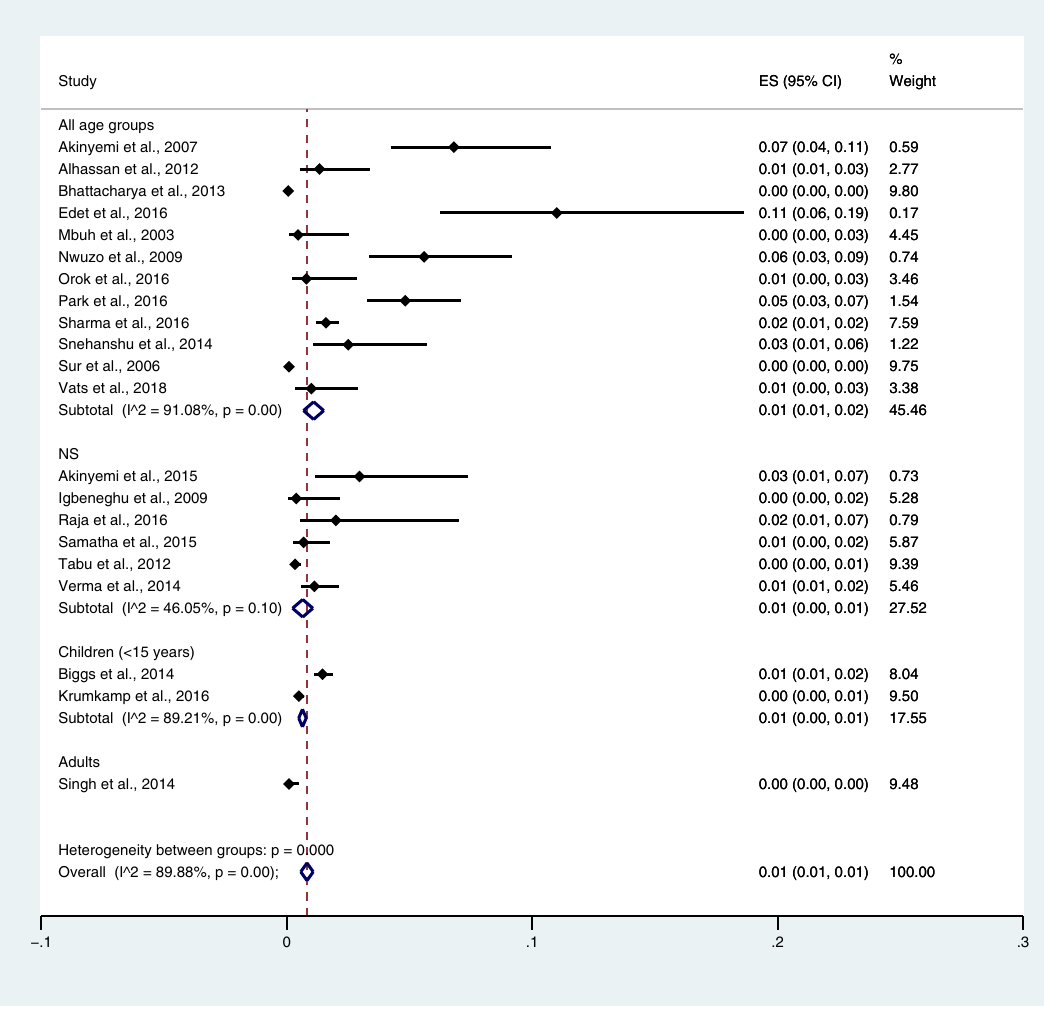
Figure 6. Pooled prevalence of typhoidal/NTS and malaria co-infection using blood cultures for the identification of Salmonella spp. infection stratified by age groups. ES proportion estimate (multiply 100 units for interpreted as prevalence estimate), CI confidence interval, NS not spp. was 17% in children (95% CI 6–29%; I 2 , 33.3%) (Fig. 22). The pooled prevalence rate of malaria infec- tion among patients with NTS, which was estimated from six studies 17,20,27,29,31,49 , was 43% in children (95% CI 32–53%; I 2 , 89.1%) (Fig. 23). Probability of Plasmodium spp. and Salmonella spp. co‑infections. The prob- ability of Plasmodium spp. and Salmonella spp. co-infections was estimated from 46 studies 35–38,40,41,43–47,50–53,57,59,61,64–66,68,70,71,73,75,76,81,82,84,87,90–93,95–97,99–104,106,108 , which reported the following param- eters: total number of Plasmodium spp. and Salmonella spp. co-infections, total number of malaria, total number of malaria without typhoid, and total number of febrile patients without malaria/typhoid. Plasmodium spp. and Salmonella spp. co-infections in all age groups occurred by chance (p = 0.126; odds ratio, 1.51; 95% CI 0.89–2.58; I 2 , 95.7%), whereas Plasmodium spp. and Salmonella spp. co-infections in children did not (p < 0.0001; odds ratio, 0.36; 95% CI 0.23–0.58; I 2 , 73.9%). No association between Plasmodium spp. and Salmonella spp. infec- tions was observed in the NS age group (p, 0.24; odds ratio, 0.40; 95% CI 0.09–1.85; I 2 , 86%) or adults (p, 0.799; odds ratio, 1.14; 95% CI 0.41–3.16; I 2 , 94%). Overall, Plasmodium spp . and Salmonella spp. co-infection occurred by chance (p, 0.987; odds ratio, 1.00; 95% CI 0.68–1.49; I 2 , 95.2%) (Fig. 24). A significantly higher odds ratio of co-infection was reported in Nigeria 57,59,82,90,95,97,101 , Cameroon 40 , India 104 , and Pakistan 102 , whereas a signifi- cantly lower odds ratio of co-infection was found in Nigeria 36,47,51 , Cameroon 73,92,93 , Pakistan 52,70 , Ghana 41,53 , Tanzania 44 , Kenya 60 , and India 43,71 . Outcomes of malaria and typhoidal/NTS co‑infections. A limited number of studies reported clini- cal outcomes of patients with co-infections (Table S2). Five studies 60,63,79,80,92 reported outcomes of co-infection. Among those studies, three studies 60,80,92 reported outcomes of malaria and NTS co-infections, and one study 63